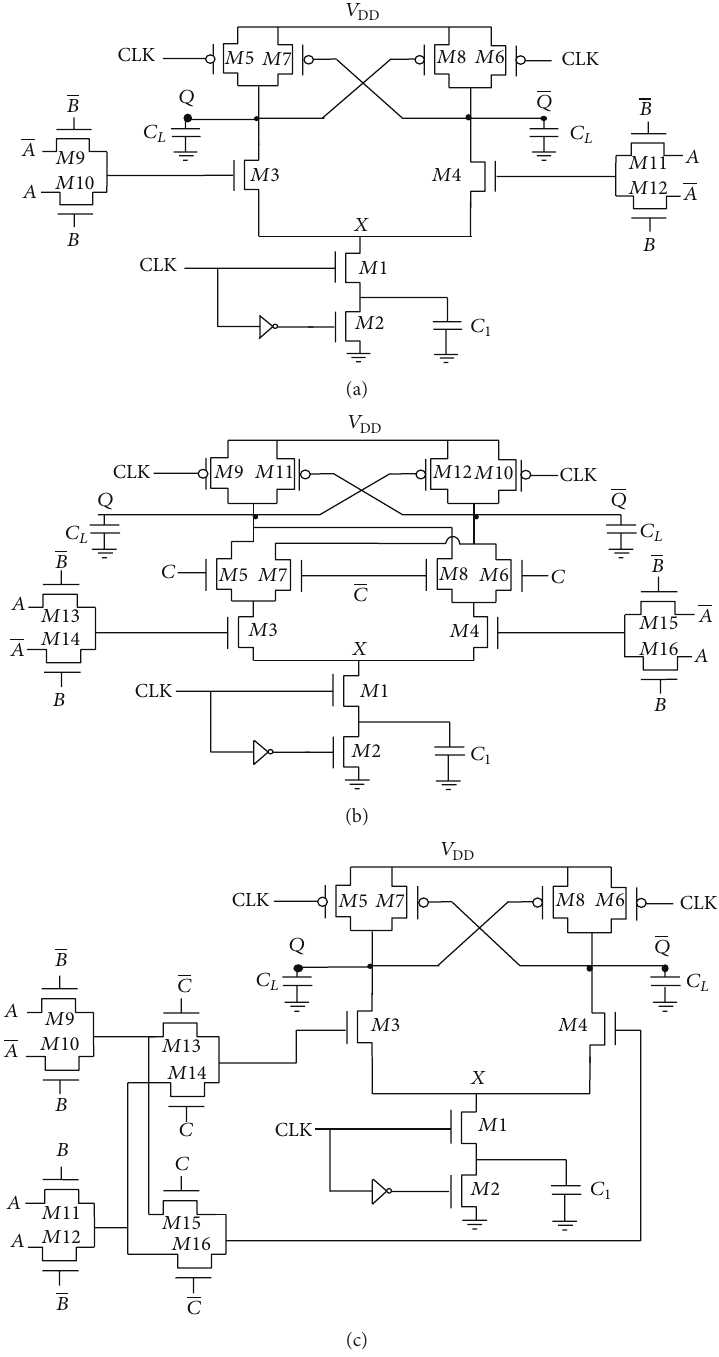
Figure 4: Proposed H-DyCML gates: (a) 2-input XOR gate; (b) 3-input XOR gate with two levels of source-coupled transistor pair in the PDN; (c) 3-input XOR gate with single level of source-coupled transistor pair in the PDN. voltage ( 𝑉 OH ) of 𝑉 DD − 𝑉 𝑇,𝑛 , where 𝑉 𝑇,𝑛 is the